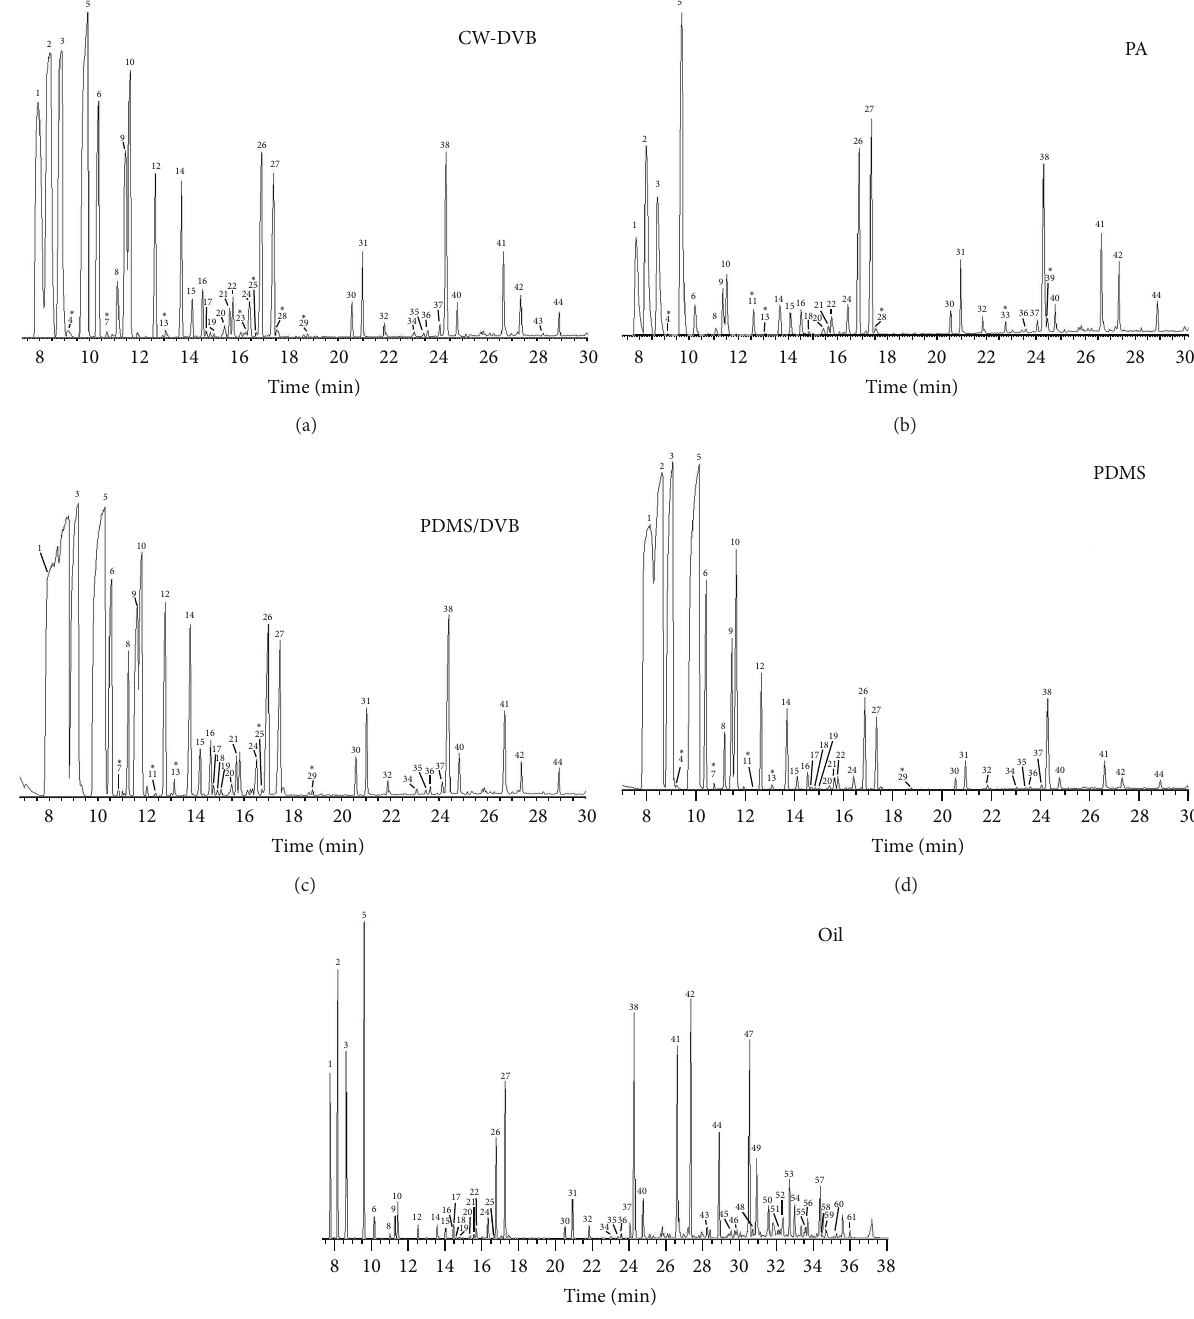
Figure 1: Typical total ion chromatograms (TIC) of J. ribifolia oil obtained by GC-MS and volatile compounds determined by HS-SPME- GC-MS ∗ compounds identified only in volatile fraction of oil: (4) 2,3,4-trimethyl-2-cyclopenten-1-one, (7) 𝛼 -phellandrene; (11) 3-carene, (13) trans- 𝑝 -mentha-2,8-dienol, (23) pinocamphone, (28) D-verbenon, (29) 1,3,3-trimethyl-2-(2-methyl-cyclopropyl)-cyclohexene, (33) 2,4- diisocyanato-1-methylbenzene, and (39) (6-hydroxymethyl-2,3-dimethylphenyl) methanol.